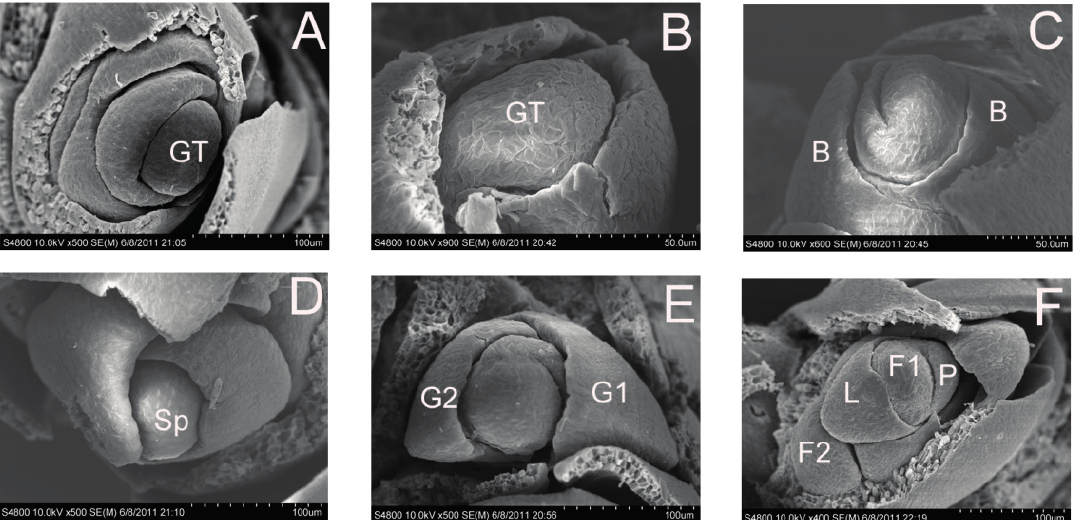
Figure 2. Morphogenesis of vegetative buds and spikelet and florets of D. latiflorus based on scanning electron microscopy (SEM) observations. ( A , B ) The apical growing tip on vegetative buds (GT-growth tip); ( C ) Bract primordium beginning differentiation (B-bract); ( D ) Initiation of spikelet primordium (Sp, spikelet primordium); ( E ) Initiation of glume primordium (G1, primordium of glume 1; G2, primordium of glume 2); ( F , G ) Initiation of lemma primordium of floret 1 (L, lemma; P, palea; F1, floret 1; F2, floret 2); ( H , I ) Initiation of stamen primordia (arrowhead) (St, stamen primordium); ( J , K ) Pistil and stamen primordia continuing developing and differentiating (St, stamen primordium; Pi, pistil). ( L ) A spikelet with some florets; a floret with six stamens and one